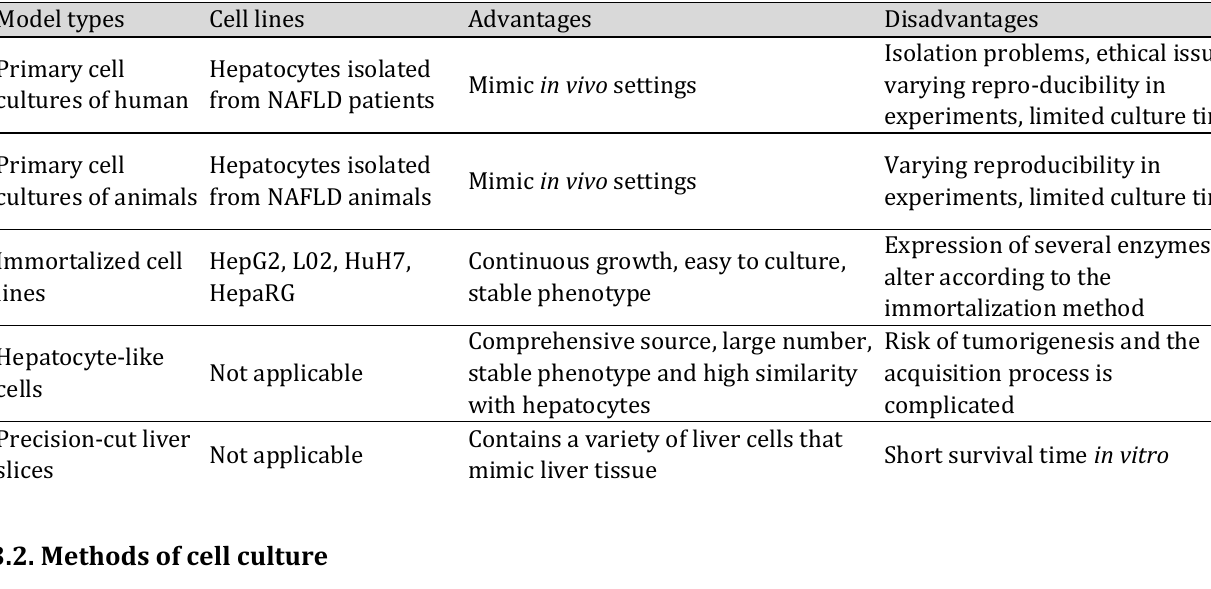
Table 1. Advantages an d disadvantages of different cell